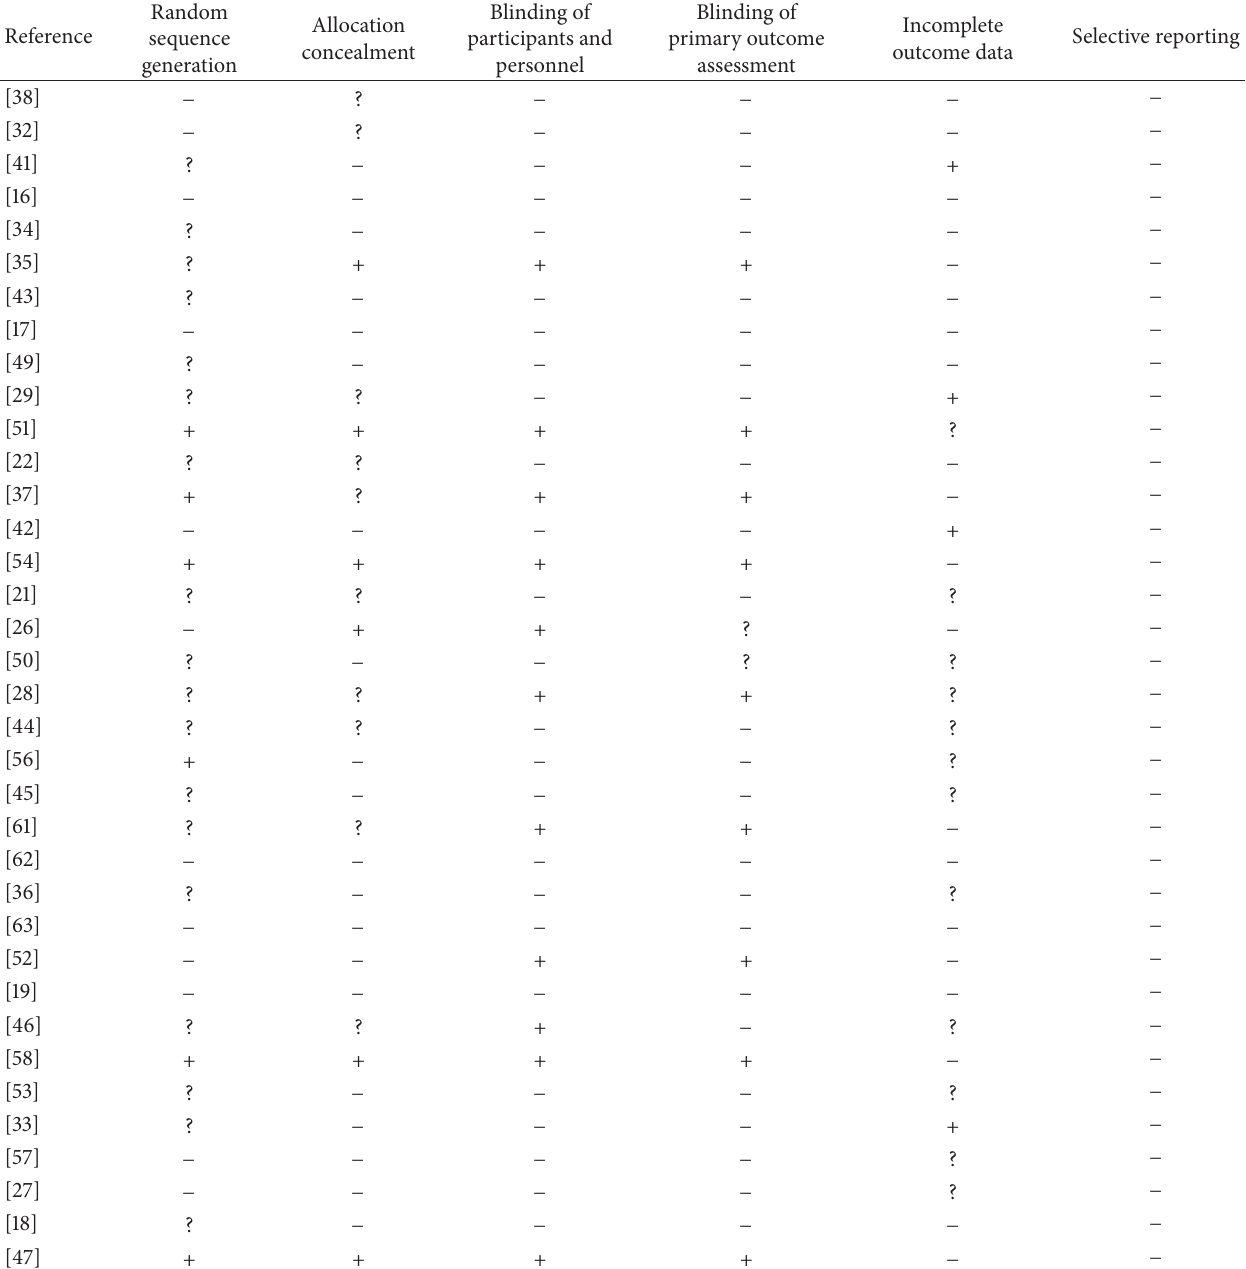
Table 3: Assessment of the risk of bias of the included